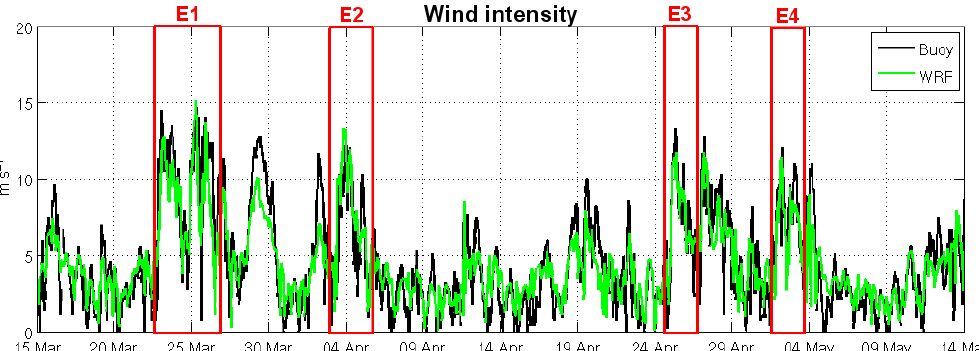
Figure 3. Comparison between the wind measured by the DB buoy (black) and the one modeled by the WRF model and used as input for the SWAN and ROMS models (green); see statistics in Table 1. The red boxes are the four wind-jet events.